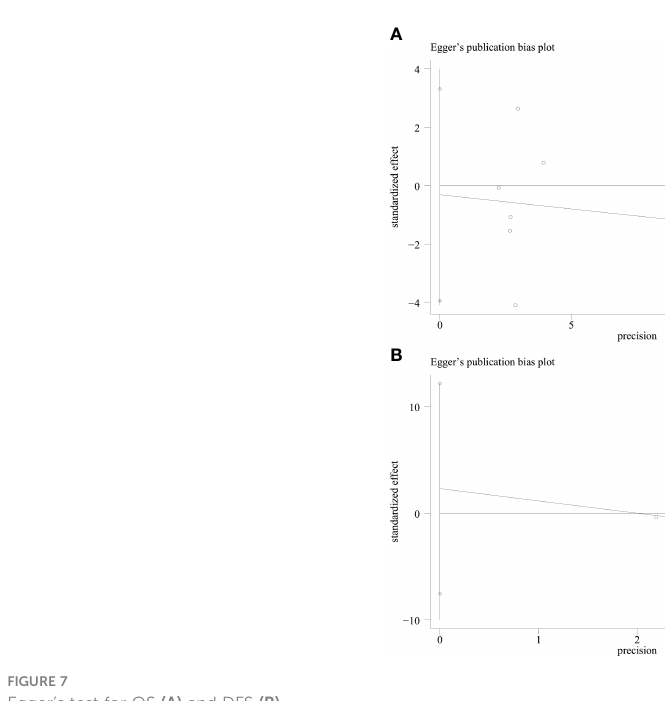
FIGURE 7 Egger ’ s test for OS (A) and DFS (B) .